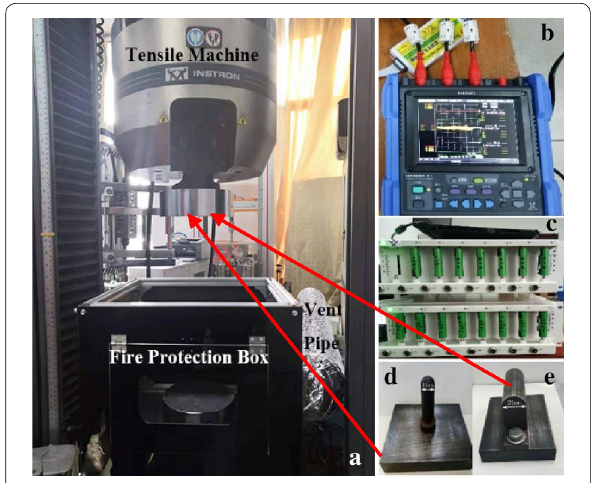
Figure 1 Experimental settings under mechanical abuse tests: a Universal tensile testing machine and safety equipment, b Voltage data recorder, c Charge-discharge tester and batteries, d Hemispherical punch, d 14 mm, e Rigid rod punch, d 24 = =